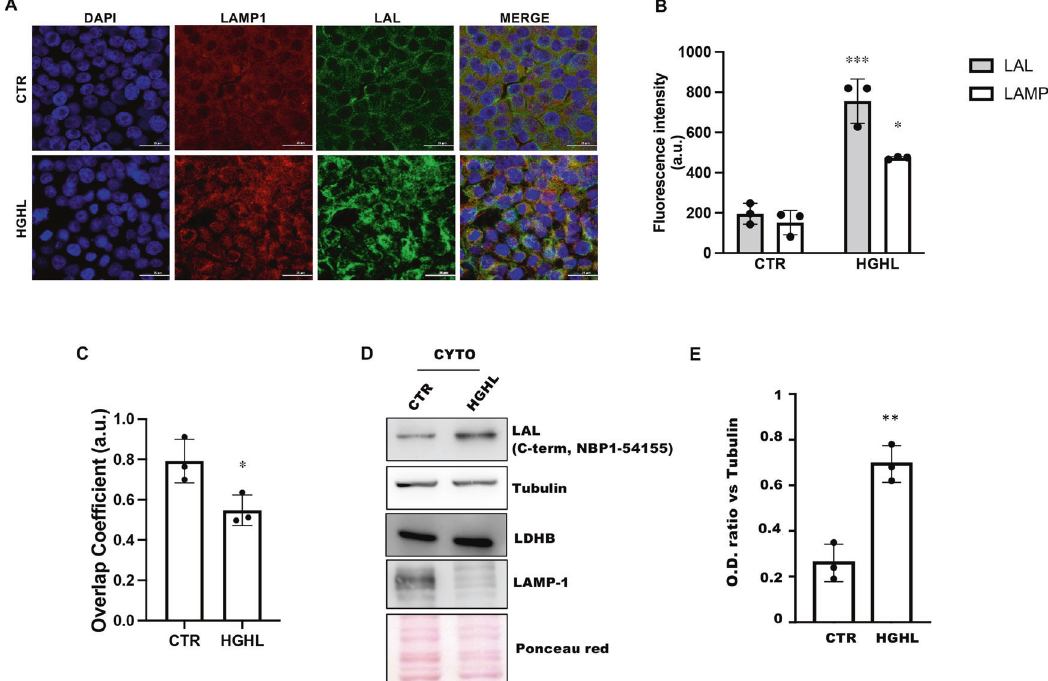
Fig. 3 LAL protein accumulates in the extra-lysosomal compartment in an in vitro model of NAFLD. Huh7 cells were cultured in high- glucose/high-lipid (HGHL) medium for 8 days. A – C Analysis of LAL localization by confocal microscopy. The lysosomal marker LAMP1 (red) and total LAL protein (individuated by antibody against C-term) (green) were shown ( A ) and their abundance ( B ) and colocalization ( C ) were evaluated. Scale bar 25 μ m. D, E Western blot analysis of LAL C-terminal domain, LDHB, Tubulin and LAMP-1 in in the cytosolic fraction ( D ) and evaluation of LAL content in the cytosolic fraction by calculating LAL to tubulin ratio through densitometric analysis ( E ). Representative images from one experiment out of three giving similar results are reported. Data are expressed as mean ± SD (* p < 0.05, ** p < 0.01 *** p < 0.001, vs CTR; n = Table 1. Mean age was just above 50 years and the majority of patients were male (60%). As expected, BMI was in the range of obesity and a high prevalence of diabetes and hypertension was observed. According to the Brunt ’ s criteria, NASH was diagnosed in 50 patients (57.5%) and all the stages of liver fi brosis were